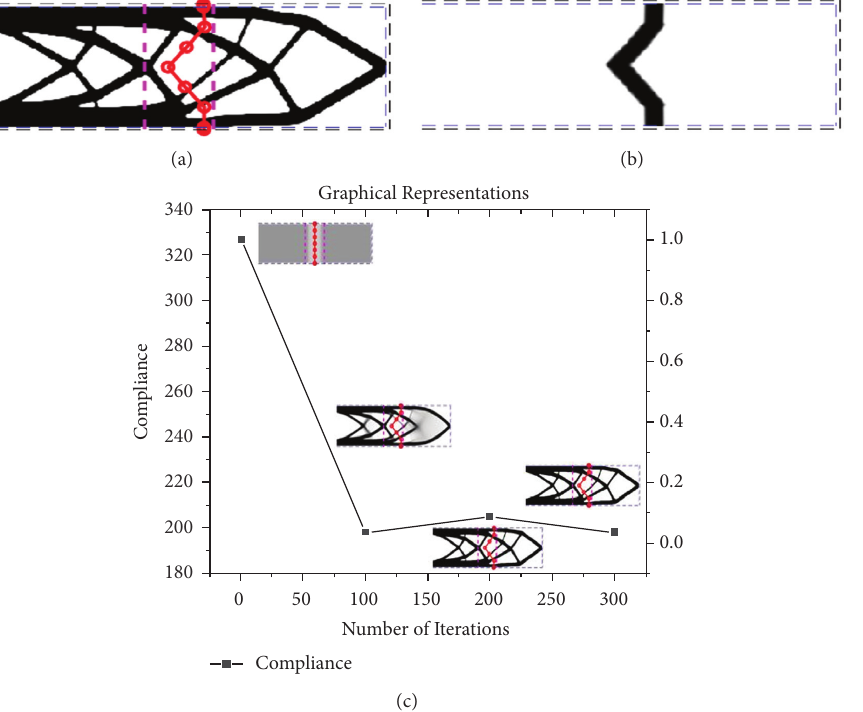
Figure 4: Optimized topologies and compliance for various constraints values. (a) f � 194, r ations � 300. (b) Shape of optimized projection area. (c) Graphical